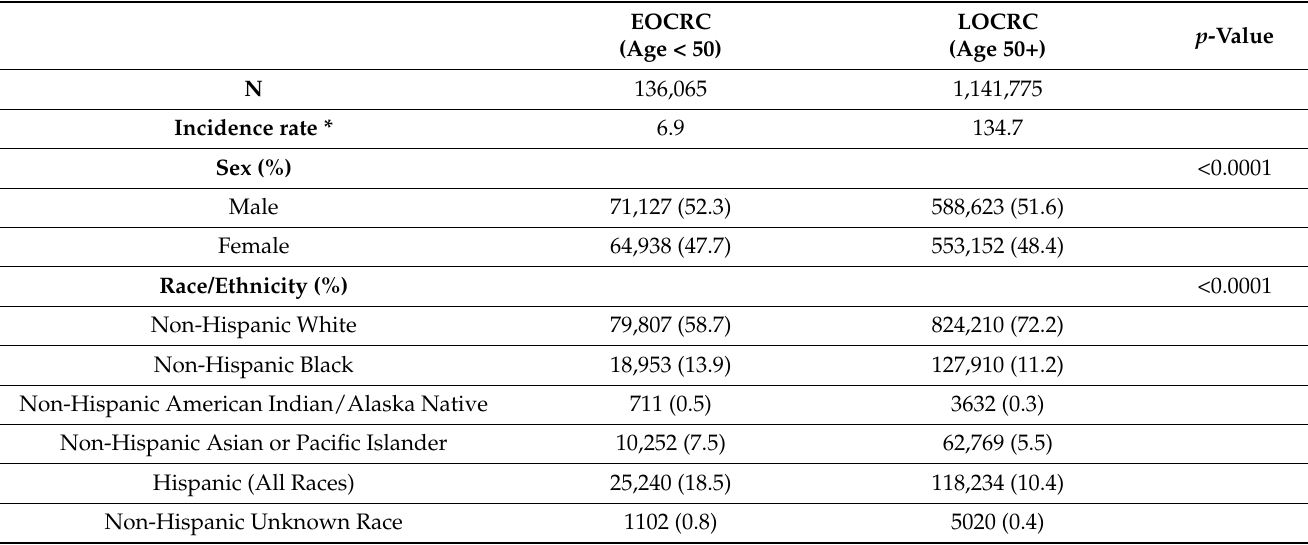
Table 2. Patient characteristics of EOCRC and LOCRC in the study